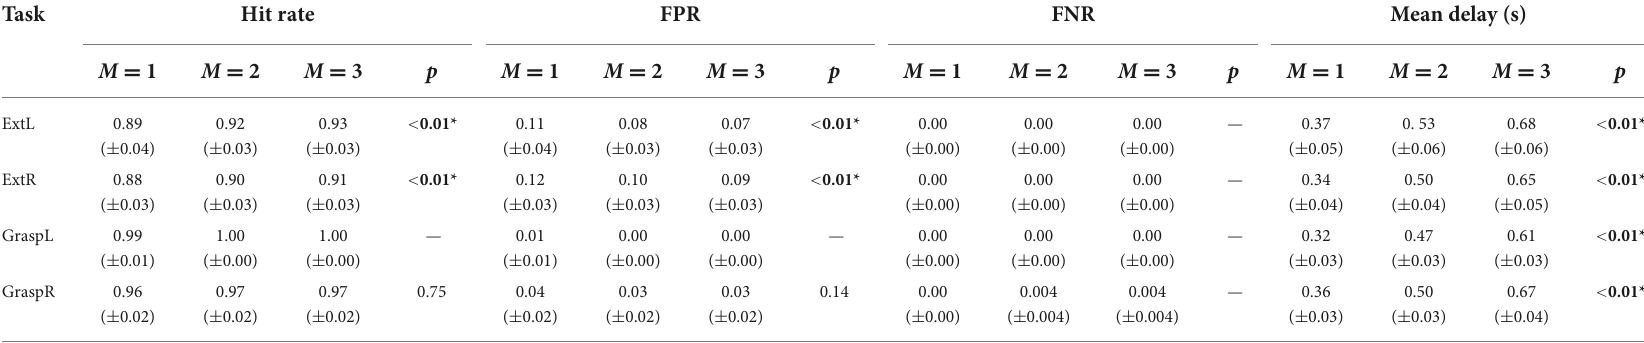
TABLE 1 Pseudo-online classification performances reported as mean ± standard error across 13 healthy participants for each movement task. Task